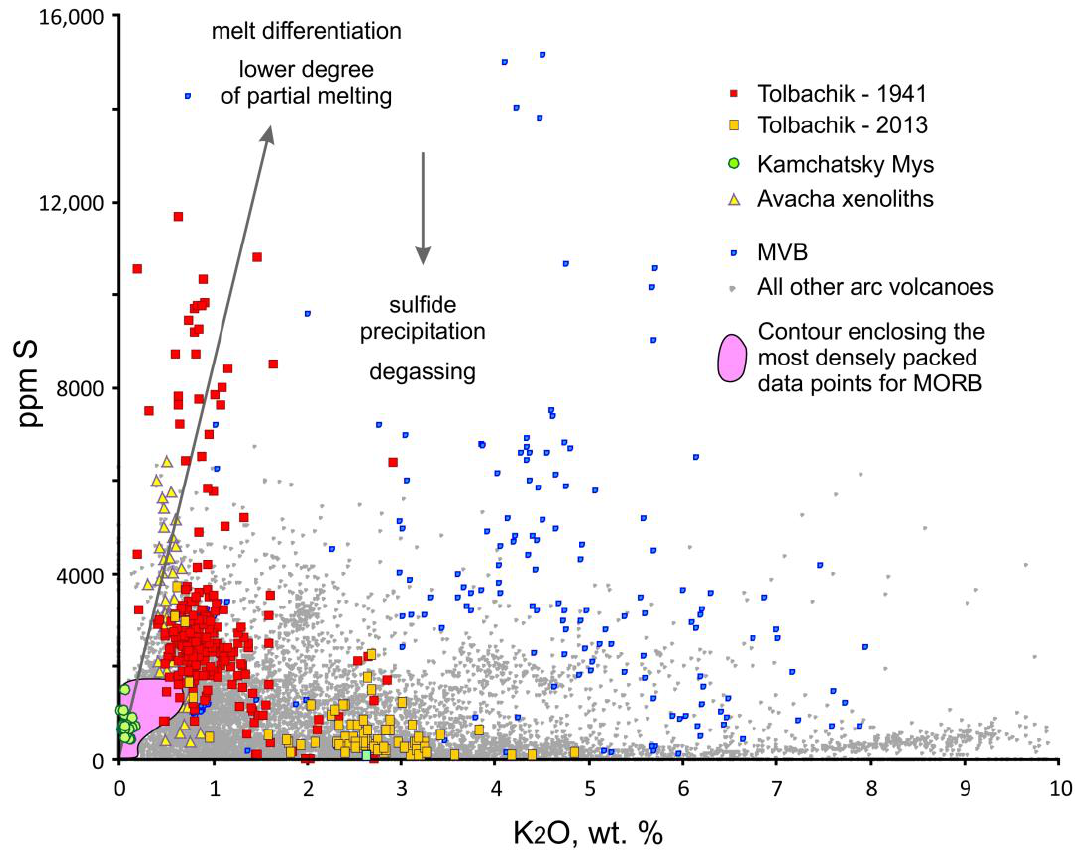
Figure 10. Variation diagram for K 2 O (wt.%) vs. S (ppm) for MI from arc volcanoes here and worldwide (sourced from the GEOROC database).